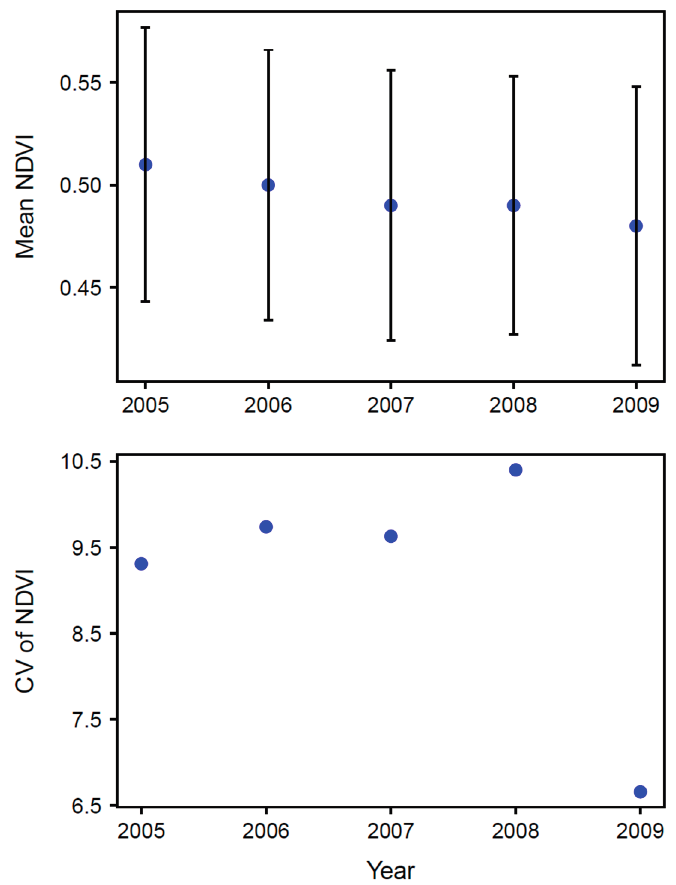
Figure 6. Mean NDVI ( top ) and coefficient of variation (CV) of NDVI ( bottom ) of the 800 random points located within ponderosa pine STARFM pixels. Mean NDVI error bars represent ± 1 standard